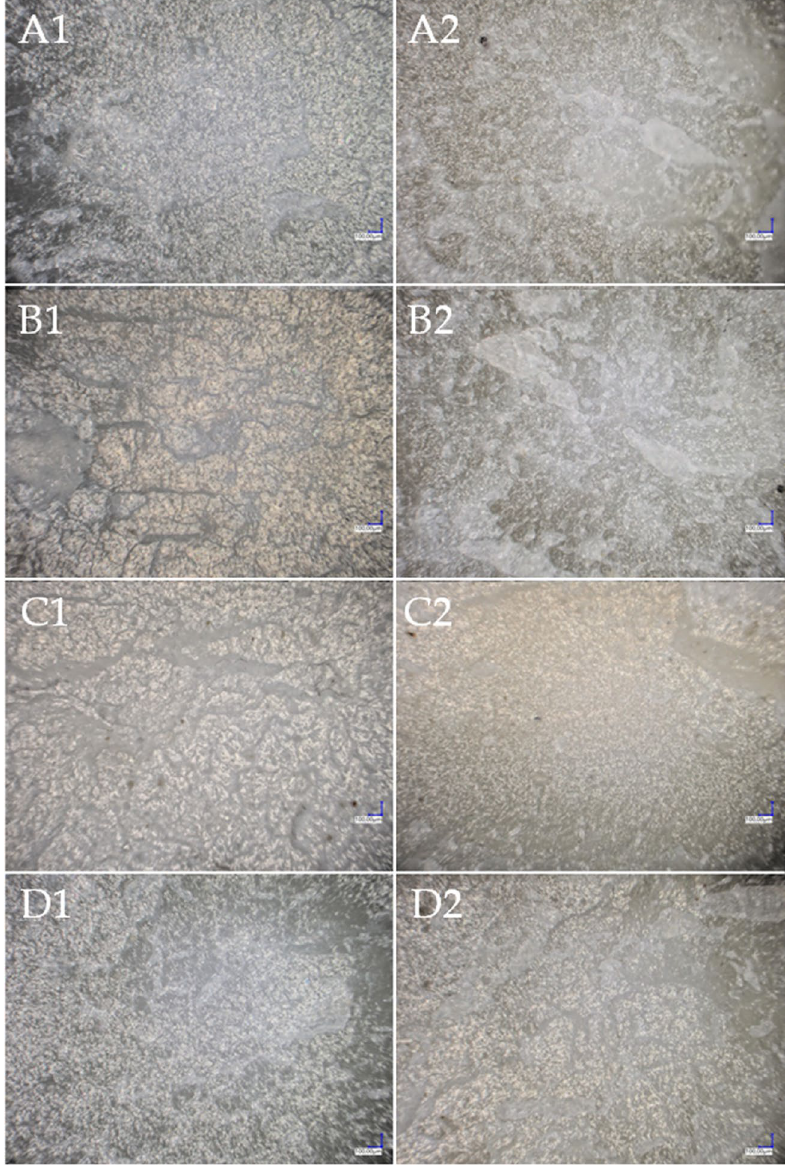
Figure 17. Composite fractures; ( A1 ) 2.5B, ( A2 ) 10B, ( B1 ) 2.5B/0.5BW, ( B2 ) 10B/0.5BW, ( C1 ) 2.5B/1BW, ( C2 ) 10B/1BW, ( D1 ) 2.5B/0.5SW, ( D2 )